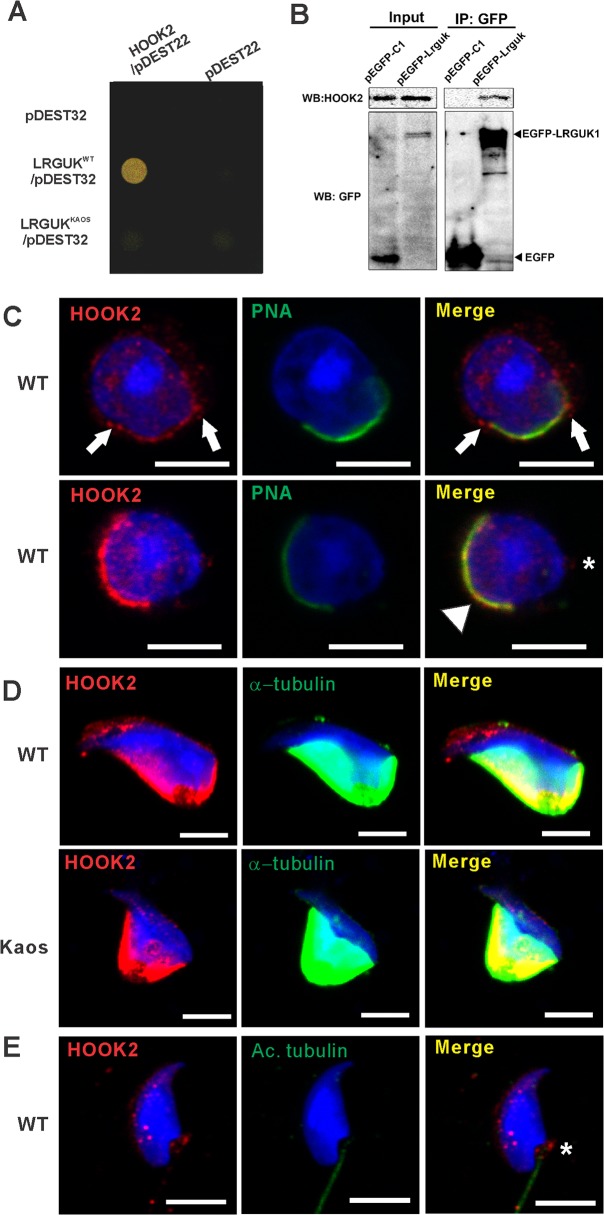
LRGUK-1 binds to HOOK2.
(A) Growth of yeast carrying wild type LRGUK-1 (LRGUKWT/pDEST32) and HOOK2 (HOOK2/pDEST22) compared to those carrying LRGUKKaos (LRGUKKaos/pDEST32) and HOOK2 (HOOK2/pDEST22), and empty pDEST32 and pDEST22 vectors. Binding was absent (i.e. no growth) when empty vectors were used as a negative control. (B) Confirmation of the interaction between LRGUK-1 and HOOK2 by immunoprecipitation from HEK293 cells expressing EGFP-tagged LRGUK-1. EGFP-tagged LRGUK-1 was immunoprecipitated using GFP antibody-conjugated beads (anti-GFP-Trap-A beads), and immunoblotting was performed using HOOK2 antibody to detect the interaction between the EGFP-tagged LRGUK-1 and endogenous HOOK2. pEGFP-C1 represents a negative control which over-expressed EGFP protein only. Input: whole cell lysates of transfected HEK293 cells. (C) The localization of HOOK2 (red) in WT round spermatids, co-labelled with PNA (green) to mark the acrosome. HOOK2 was present within the developing acrosome/acroplaxome (arrowhead), at a region consistent with the leading edge of the acrosome and acroplaxome (arrows) and at a site consistent with the basal body (asterisk). (D) The localisation of HOOK2 (red) onto the microtubules (α-tubulin, green) of the manchette in WT and Lrguk
Kaos/Kaos elongating spermatids. Scale bar = 5 μm. (E) HOOK2 (red) within caudal epididymal sperm. Acetylated (Ac) tubulin was used as an axoneme marker. The asterisk indicates HOOK2 in the sperm basal body. Scale bar = 5 μm. In all images, nuclei are labelled with DAPI (blue). Please see S3 Fig. for negative control images.